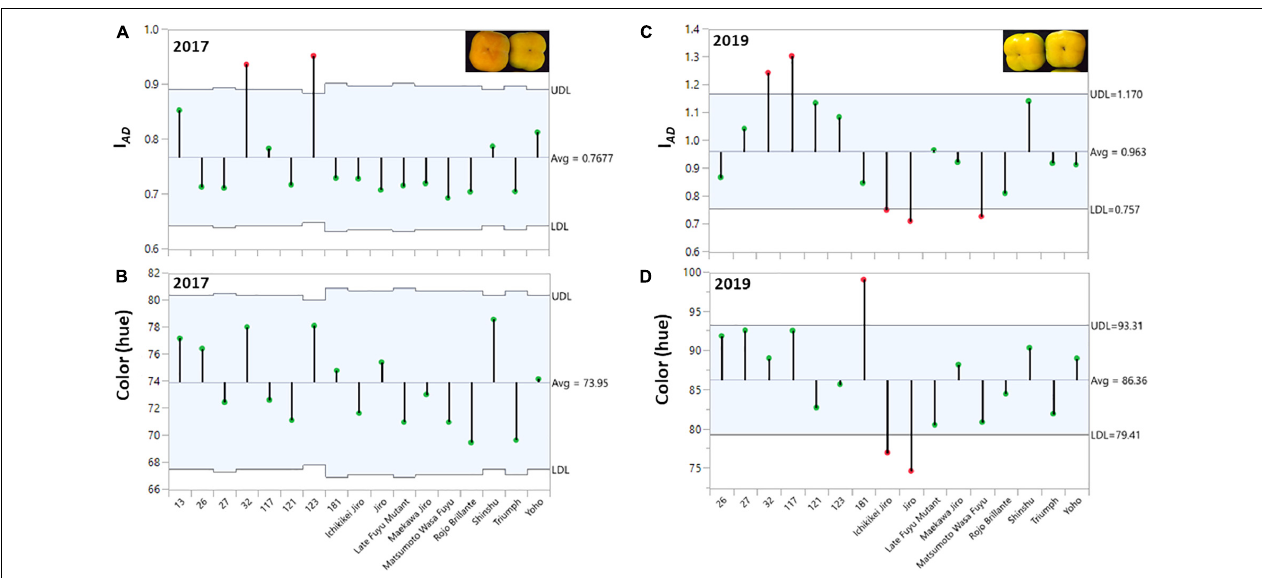
FIGURE 2 | Distribution of chlorophyll (I AD ), and color (hue) among the fruits of the persimmon cultivars in two harvests. The ANOM analysis was performed on harvested fruit. (A,B) Hue and I AD for harvest 2017; (C,D) Hue and I AD for harvest 2019. The green dots represent cultivars within the range and red dots represent cultivars with a deviation from the range at the statistical significance of p ≤ 0.001 for harvest 2017 and 2019.